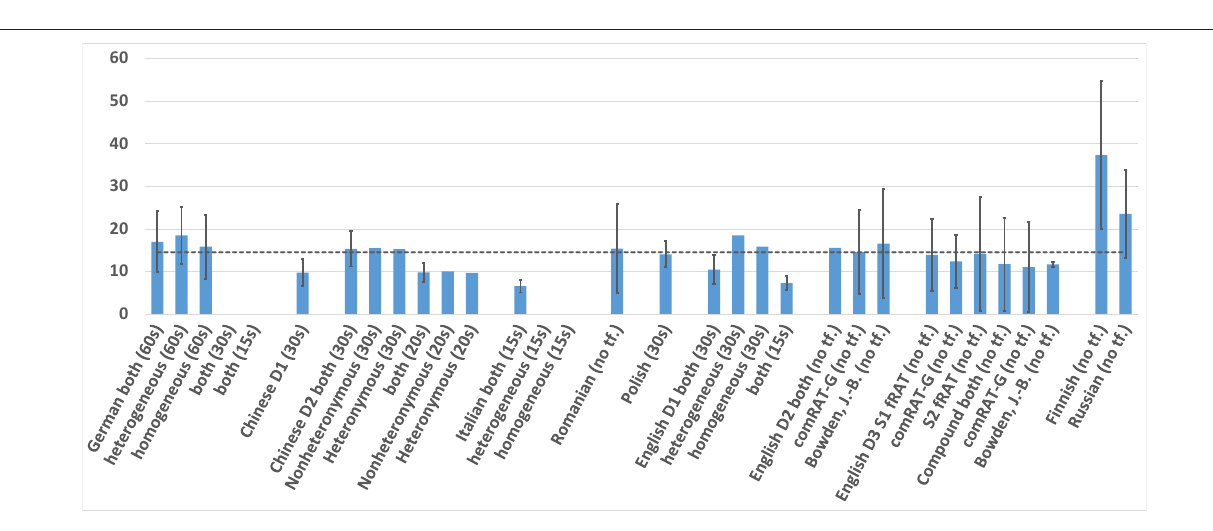
FIGURE 2 | Mean and SD Response Time (in seconds) of RAT datasets in the different languages.